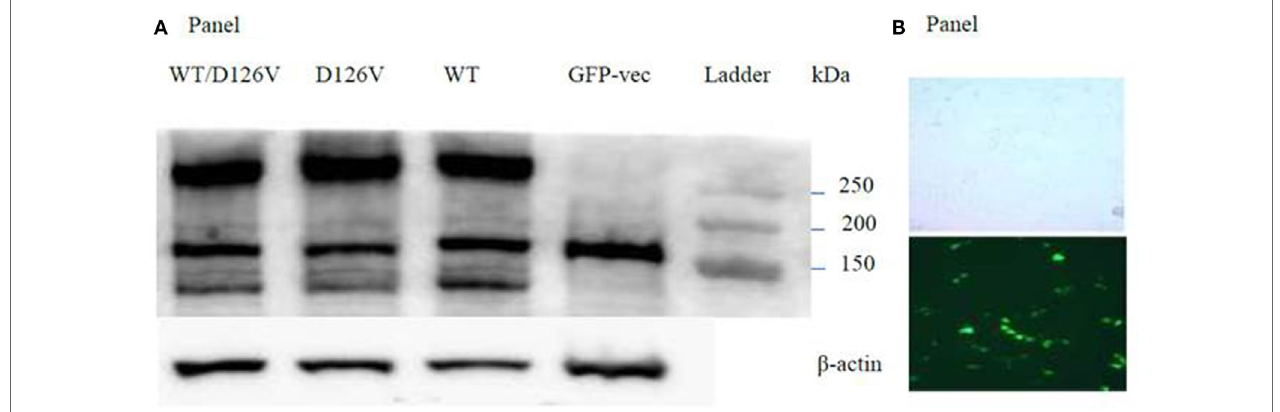
FigUre 5 | Evaluation of the WT- and the mutant calcium-sensing receptor ( CASR ) expression in transiently transfected Flp-In human embryonic kidney-293 (HEK293) cells. (a) Western blot analysis of the nuclear cell fraction, expression the band of the immature 140 kDa, the mature 160 kDa, and the functional dimeric receptor protein > 240 kDa. Lane 1: WT/D126V- CASR , lane 2: D126V- CASR , lane 3: wild-type calcium-sensing receptor (WT- CASR ), lane 4: mock-vector fused with GFP for transfections control, lane 5: ladder. WB on β -actin was used as loading control. Four additional experiments gave similar results. Panel (b) shows the light microscopy and the fluorescent microscopy of Fl-In HEK293 cells transfected with the